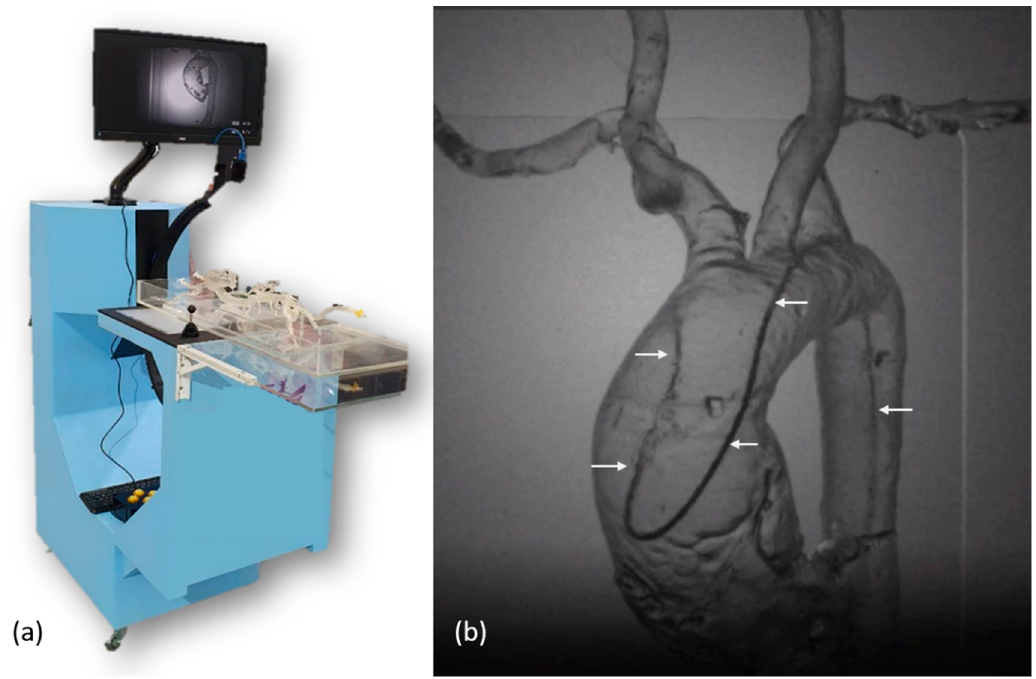
Figure 3. ( a ) Photo of the infrared imaging platform; ( b ) The infrared image of a SIM2 catheter (ar- rows) in a vascular simulator with a type I aortic arch. (arrows) in a vascular simulator with a type I aortic